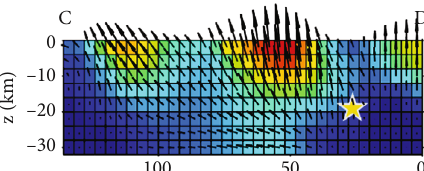
Figure 6: The coseismic slip from joint inversion of InSAR and GPS data of southern segment of BCF (Feng et al.